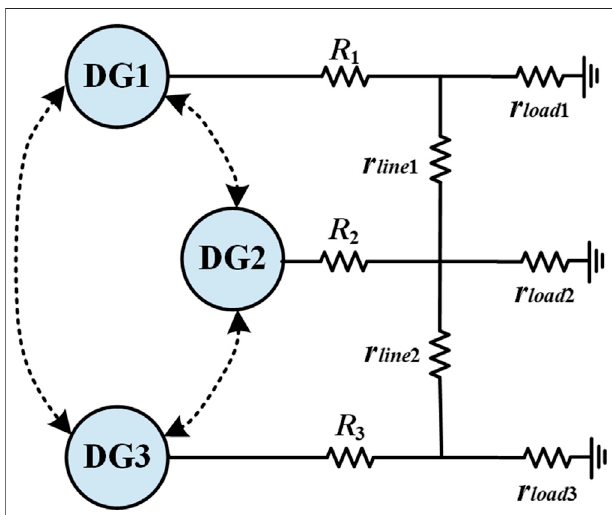
FIGURE 3 | Architecture of the test microgrid.